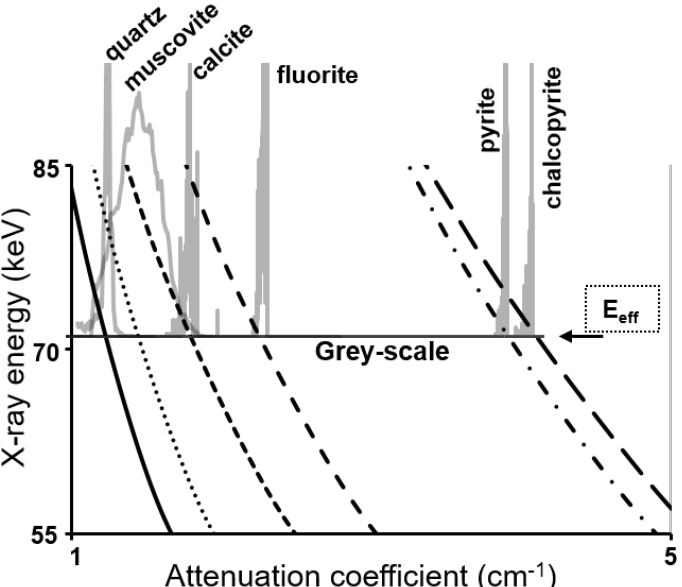
Figure 6. Histogram of individual particles (grey lines) overlapped on the plot (black lines) of the attenuation coefficients as a function of the X-ray energy for the different phases in the Qz/Py sample. The baseline of the histograms is at the E eff that was measured to be 72.8 keV (Figure S2). Note that the intersection of the attenuation coefficient lines with the grey-scale axis (at the E eff ) is close to the maximum of the main peaks found in the sample.